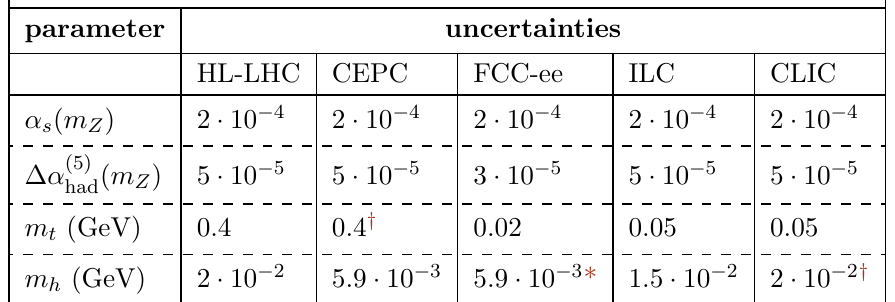
Table 4 . Gaussian errors on the SM input parameters varied in the (cid:12)ts (see subsection E.2 for m Z ). Unless the units are speci(cid:12)ed, all uncertainties are relative to the respective central value. y HL-LHC projection. *CEPC